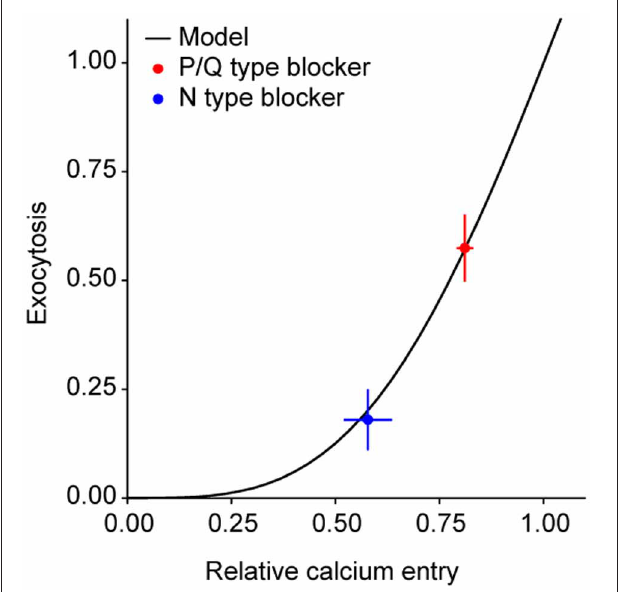
FIGURE 3 | P/Q and N-type Ca 2 + channels do not differ in their coupling to primed synaptic vesicles. Exocytosis as a function of the relative Ca 2 + entry in response to 1 AP. The model is from a fit to exocytosis vs. Ca 2 + entry data in a previous publication [Figure 2C in Ariel and Ryan (2010)]. For convenience, exocytosis and Ca 2 + have been renormalized to the expected values for 1 AP at 4mM extracellular Ca 2 + . Note the good agreement between the model and the data in the presence of